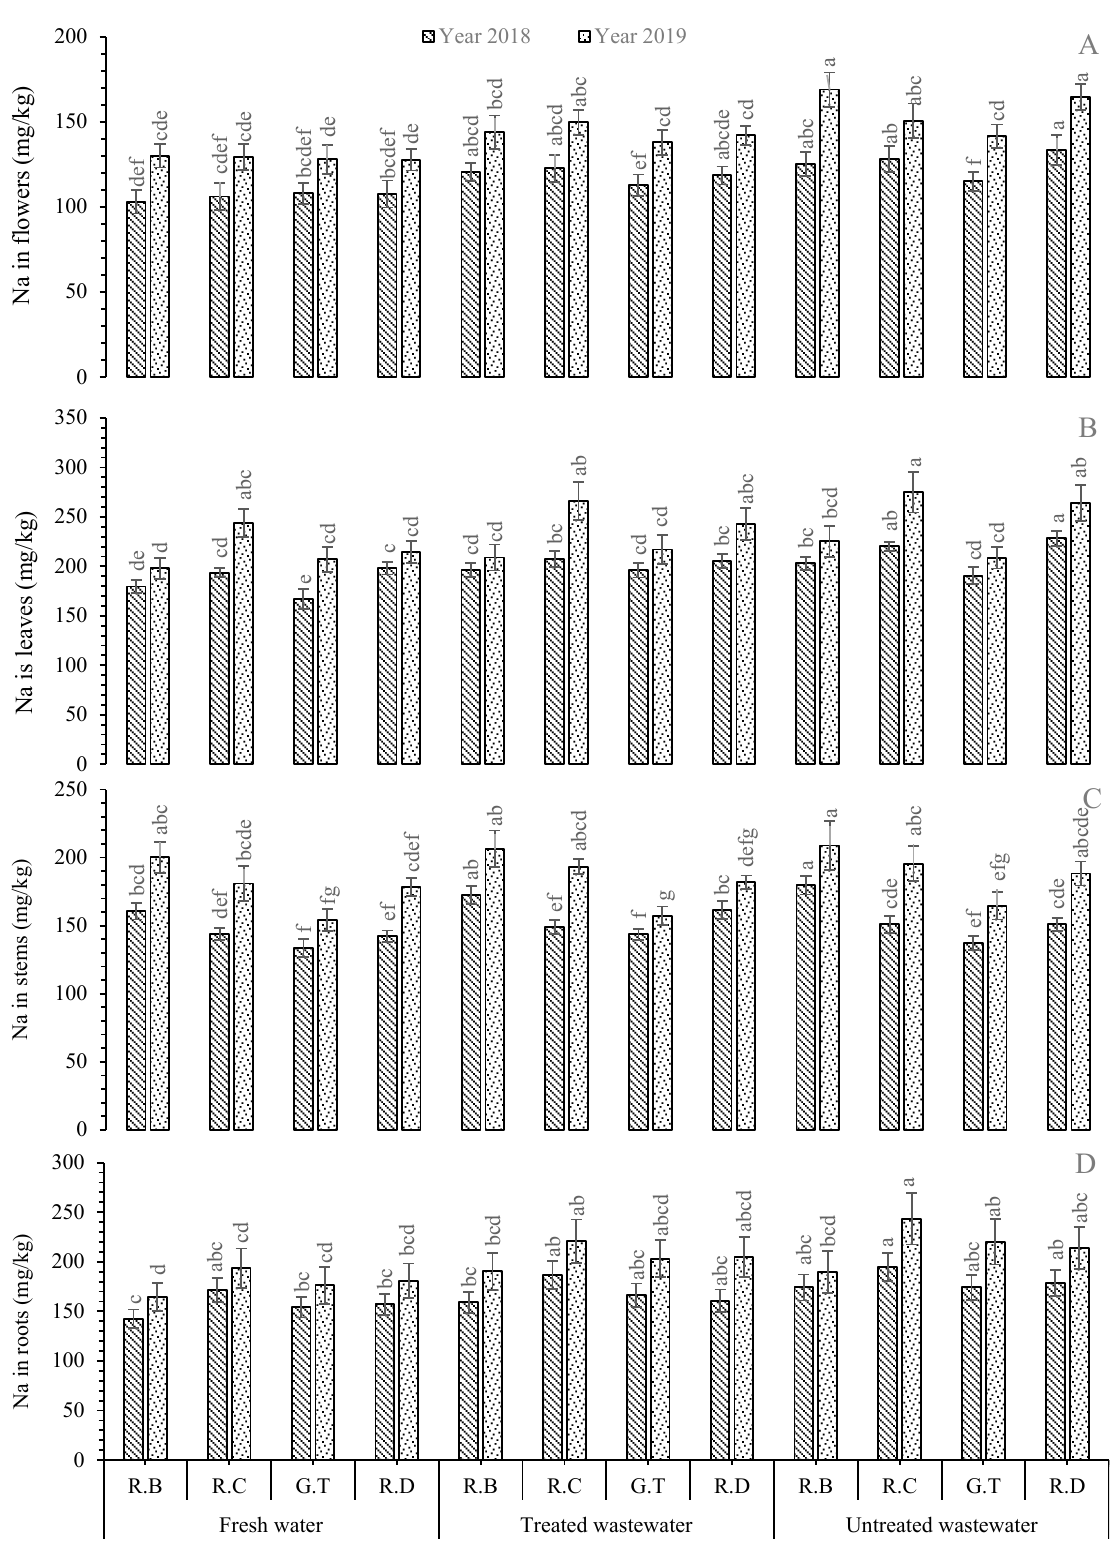
Figure 5. Mean concentration of Na in plant parts, i.e., flowers ( A ), leaves ( B ), stems ( C ), and roots ( D ), of Rosa species under different irrigations. Each vertical bar represents the average of three replicates. Different letters indicate significant differences among treatments at p ≤ 0.05 according to least significant difference test. R.B: Rosa bourboniana , R.C: Rosa centifolia , G.T: Gruss-an-teplitz, R.D: Rosa damascena